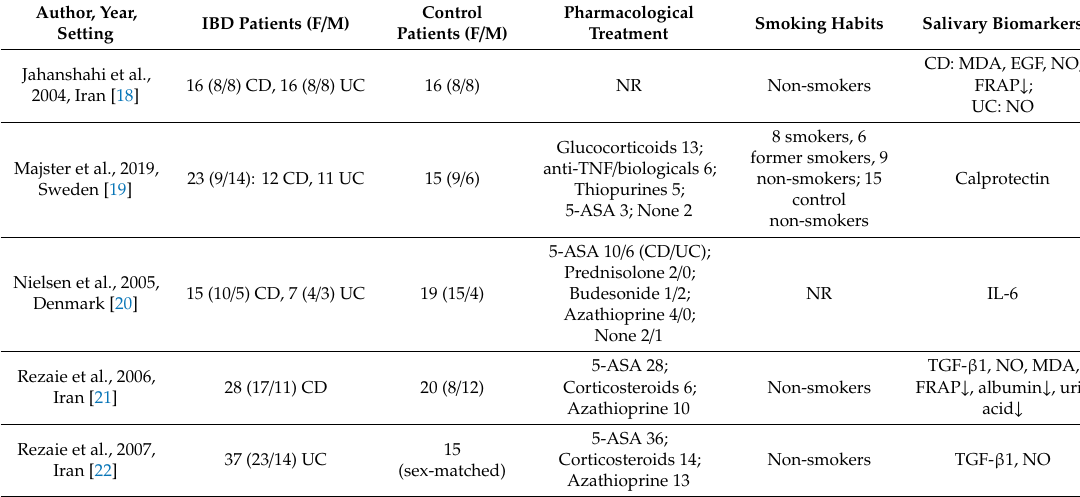
Figure 1. PRISMA flow diagram presenting the detailed search strategy. Table 1. General characteristics of included